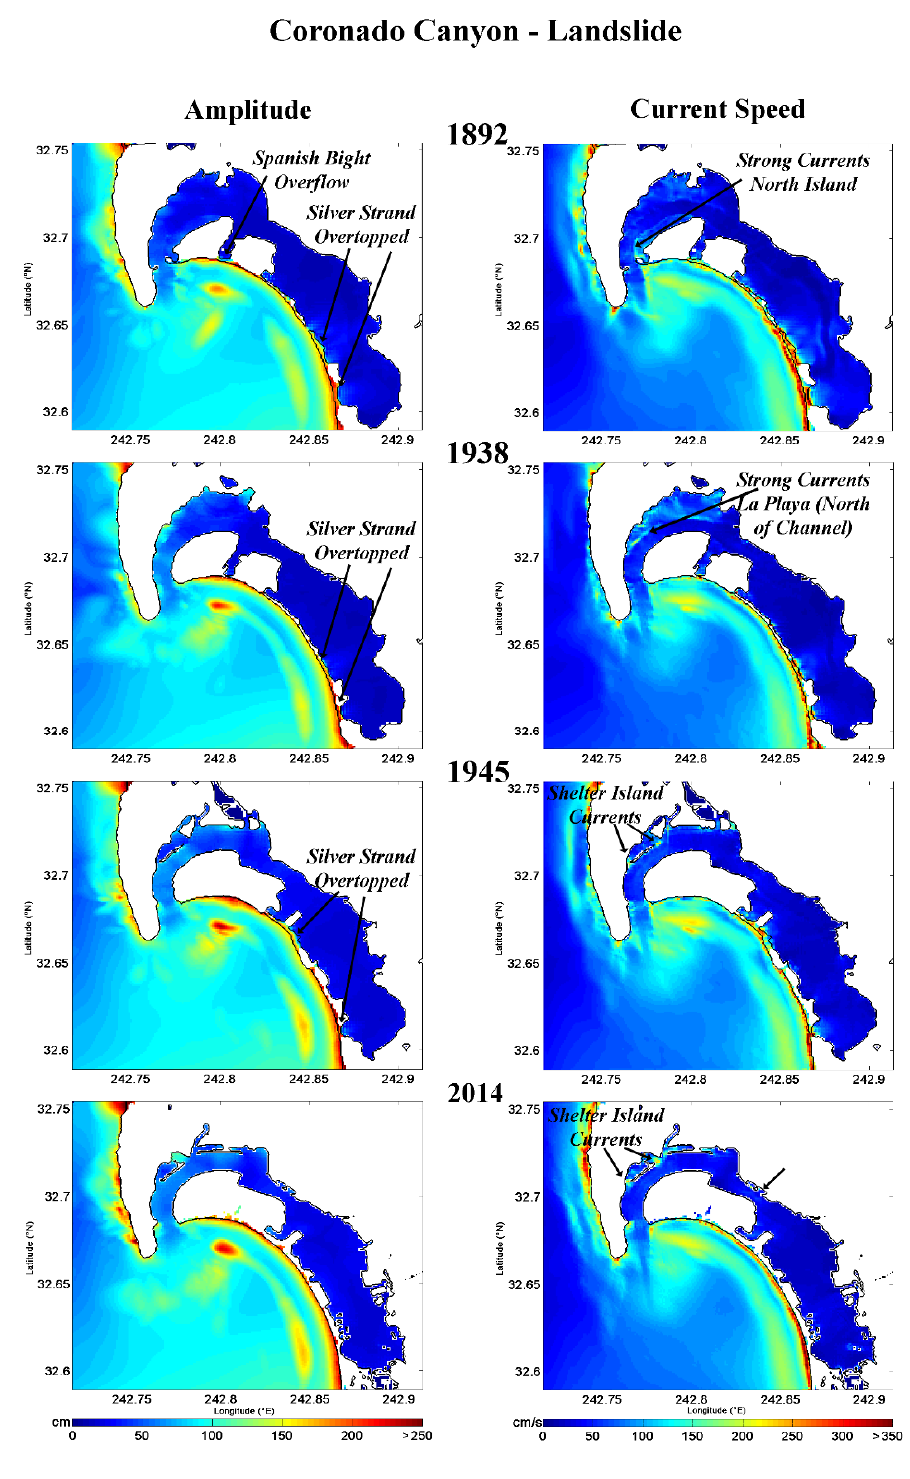
Figure 10. Maximum wave amplitude and maximum current distribution in San Diego harbor for four different configurations (1892, 1938, 1945, and 2014). A hypothetical tsunami scenario generated by a landslide on Coronado Canyon was used to investigate changes in wave dynamics as a result of anthropogenic changes. Years indicate time tagging of large changes in the harbor. Left column shows wave heights in cm; right column tsunami currents in